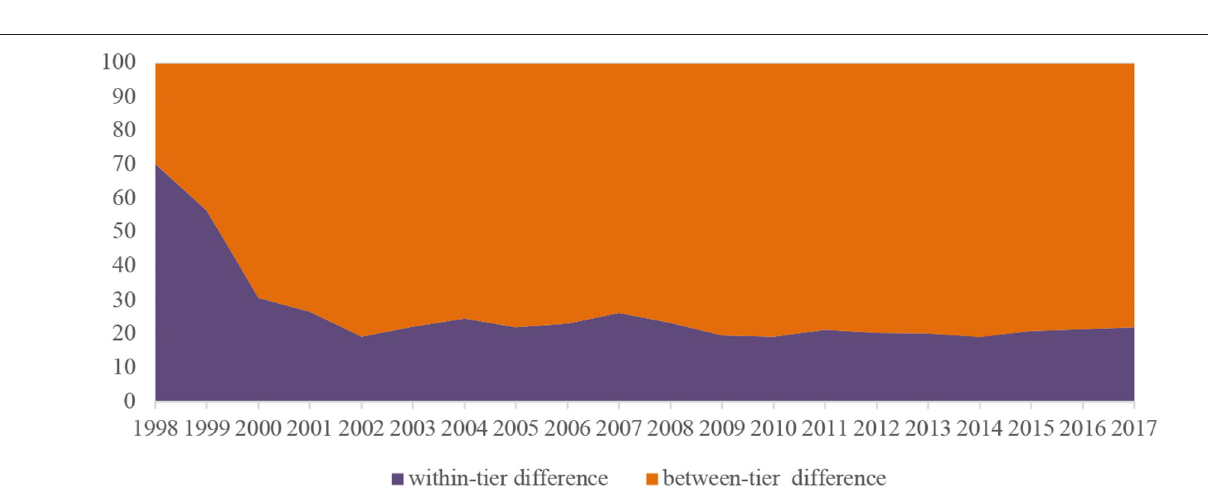
FIGURE 3 | Within-tier and between-tier differences in funding per institution among HPIs in